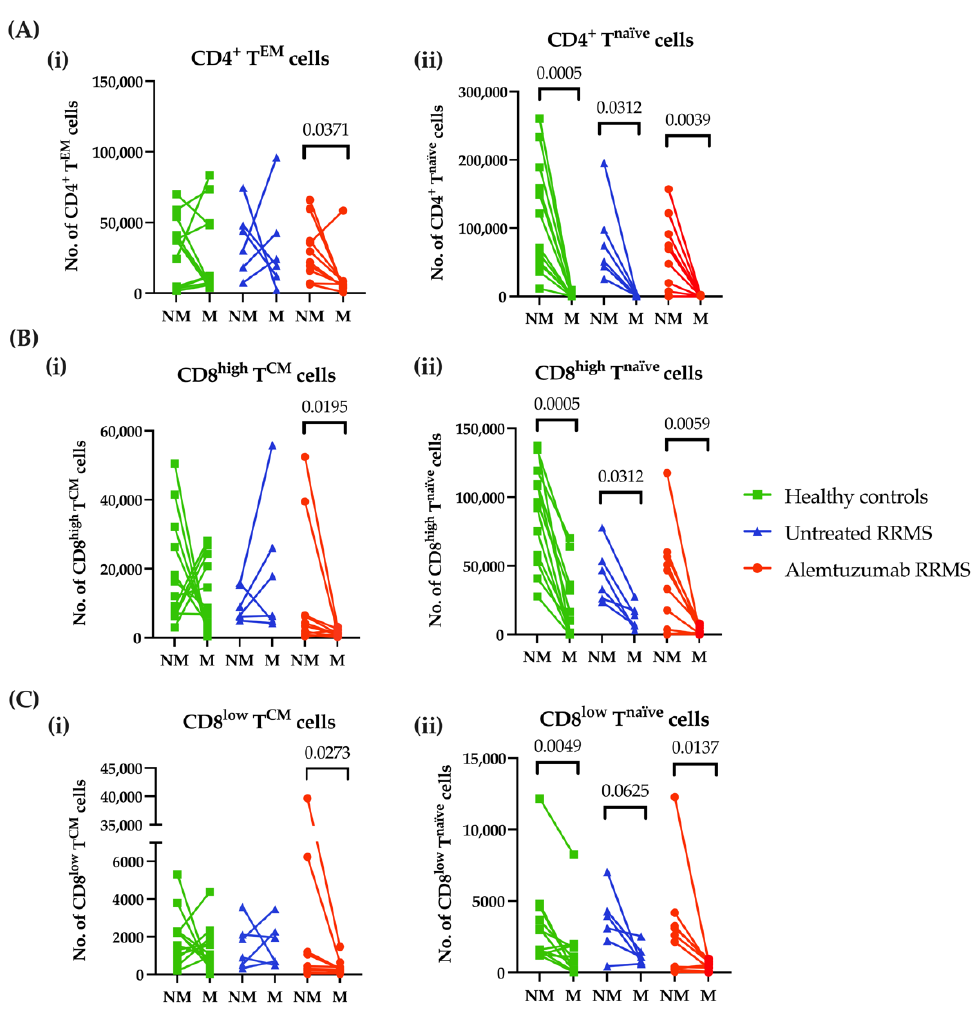
Figure 1. Alemtuzumab decreased the migratory capacity of CD4 + T EM and CD8 + T CM cells across the BBB in vitro. PBMCs were isolated from healthy controls (n = 12, green squares), untreated RRMS (n = 6, blue triangles) and alemtuzumab-treated RRMS patients (n = 10, red circles). After stimulation of the HBEC monolayer, PBMCs were added to the transwell assay and were left overnight to migrate. Non-migrated and migrated cells were harvested from the BBB model and phenotyped for analysis as total cell numbers. ( A ) The number of ( i ) CD4 + T EM cells and ( ii ) CD4 + T naïve cells. ( B ) The number of ( i ) CD8 high T CM cells and ( ii ) The CD8 high T naïve cells. ( C ) The number of ( i ) CD8 low T CM cells and ( ii ) CD8 low T naïve cells. Wilcoxon matched-pairs signed-rank test. p ≤ 0.1 are shown. NM; non-migrating, M; migrating; T CM , central memory T cells; T EM , effector memory T cells; T naïve , naïve T cells; RRMS, relapsing-remitting multiple sclerosis.